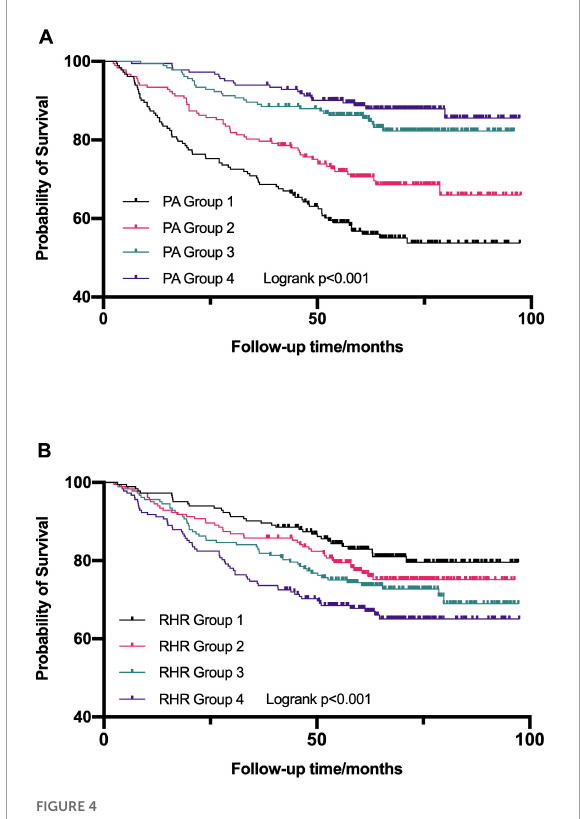
FIGURE4 Kaplan–Meier survival curves were established to assess the predictive ability for all-cause mortality in the different quartile of daily physical activity (PA) (A) and resting heart rate (RHR) (B) . PA, physical activity; RHR, rest heart